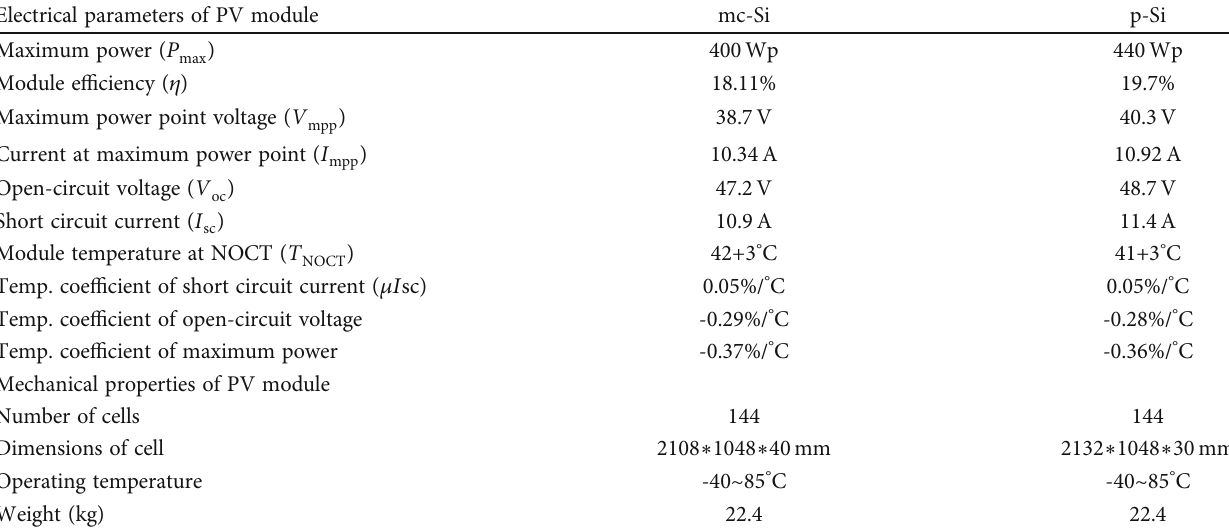
Table 1: Electrical and mechanical parameters of the installed PV modules.